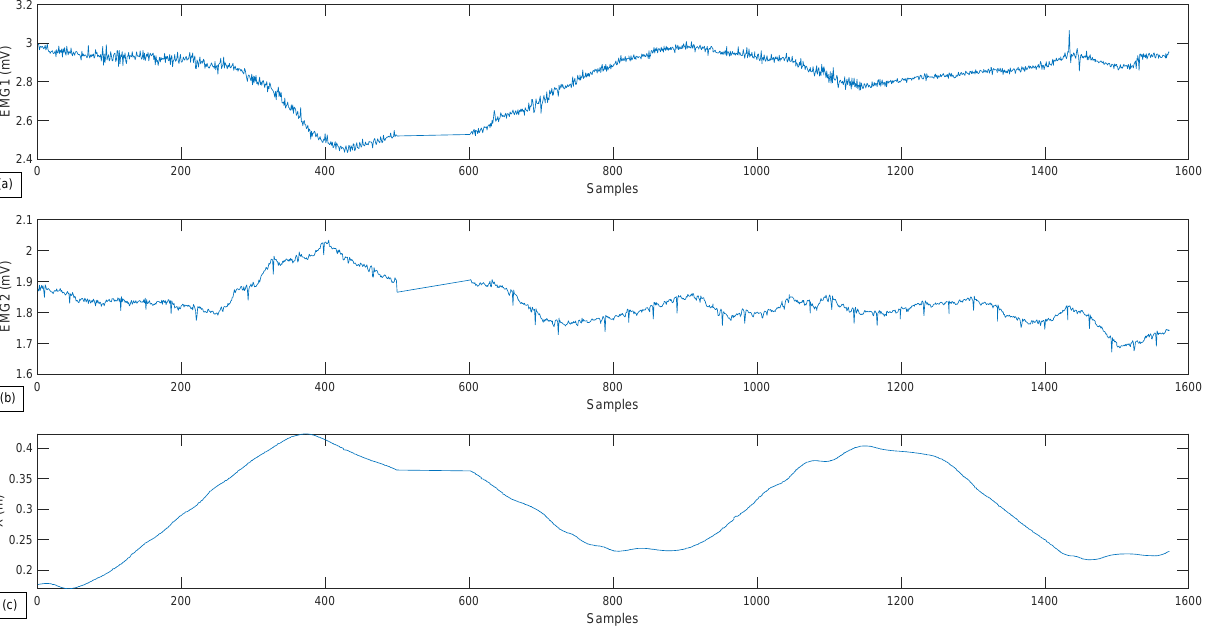
Figure 12. Experimental test for restricted active-assisted lateral shoulder rotation. ( a ) Muscle activity for the Deltoid muscle. ( b ) Muscle activity for the Latissimus Dorsi. ( c ) Robot position in x in relation to the